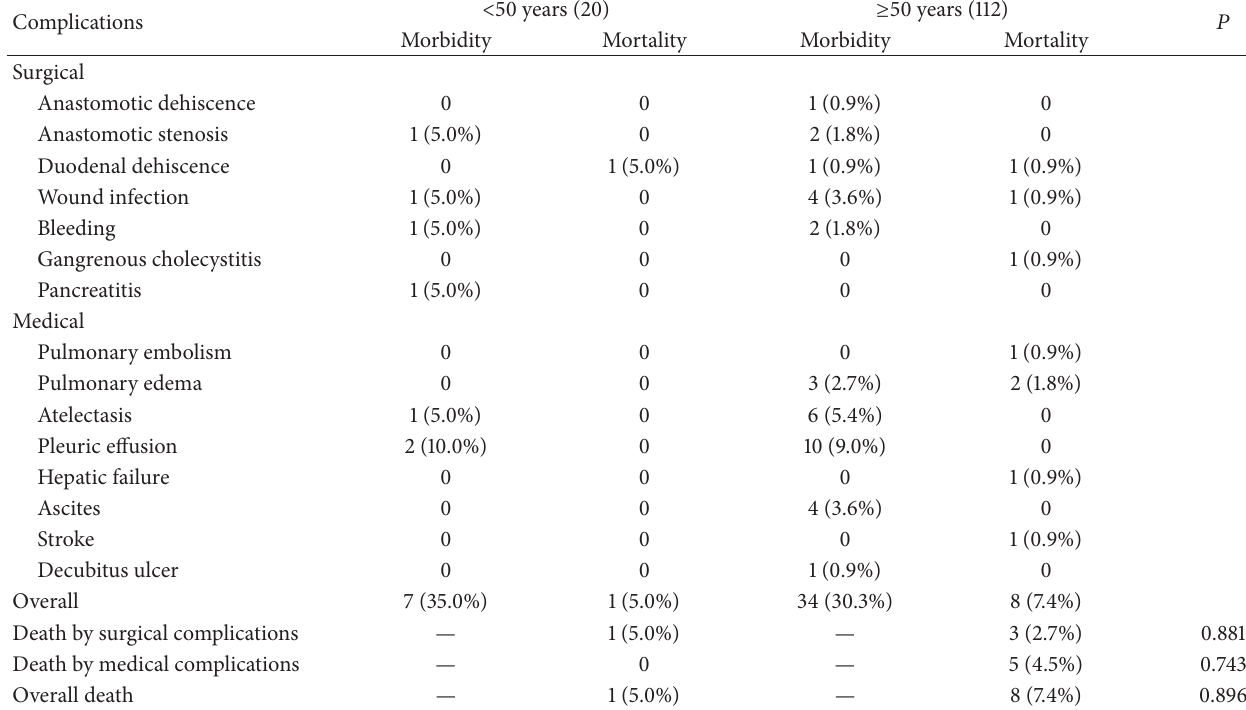
Table 4: Postoperative morbidity and related death.